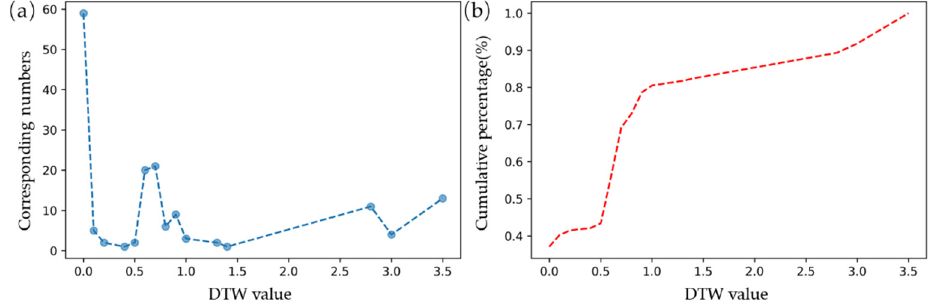
Figure 13. Distance of SL change calculated using DTW. ( a ) Line chart of the DTW result distribution. ( b ) Cumulative percentage of the DTW result.